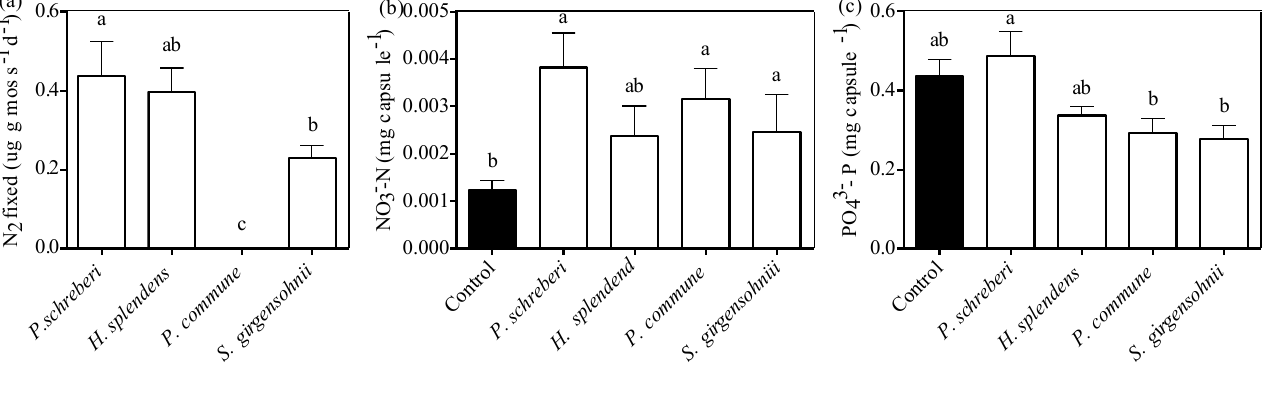
Figure 5. Biogeochemical properties associated with the four moss species at the highest moss biomass class and a moss-free control: ( a ) biological N − -N; and ( c ) resin sorbed soil PO 43 − -P. Bars show means + SE; means within soil NO 3